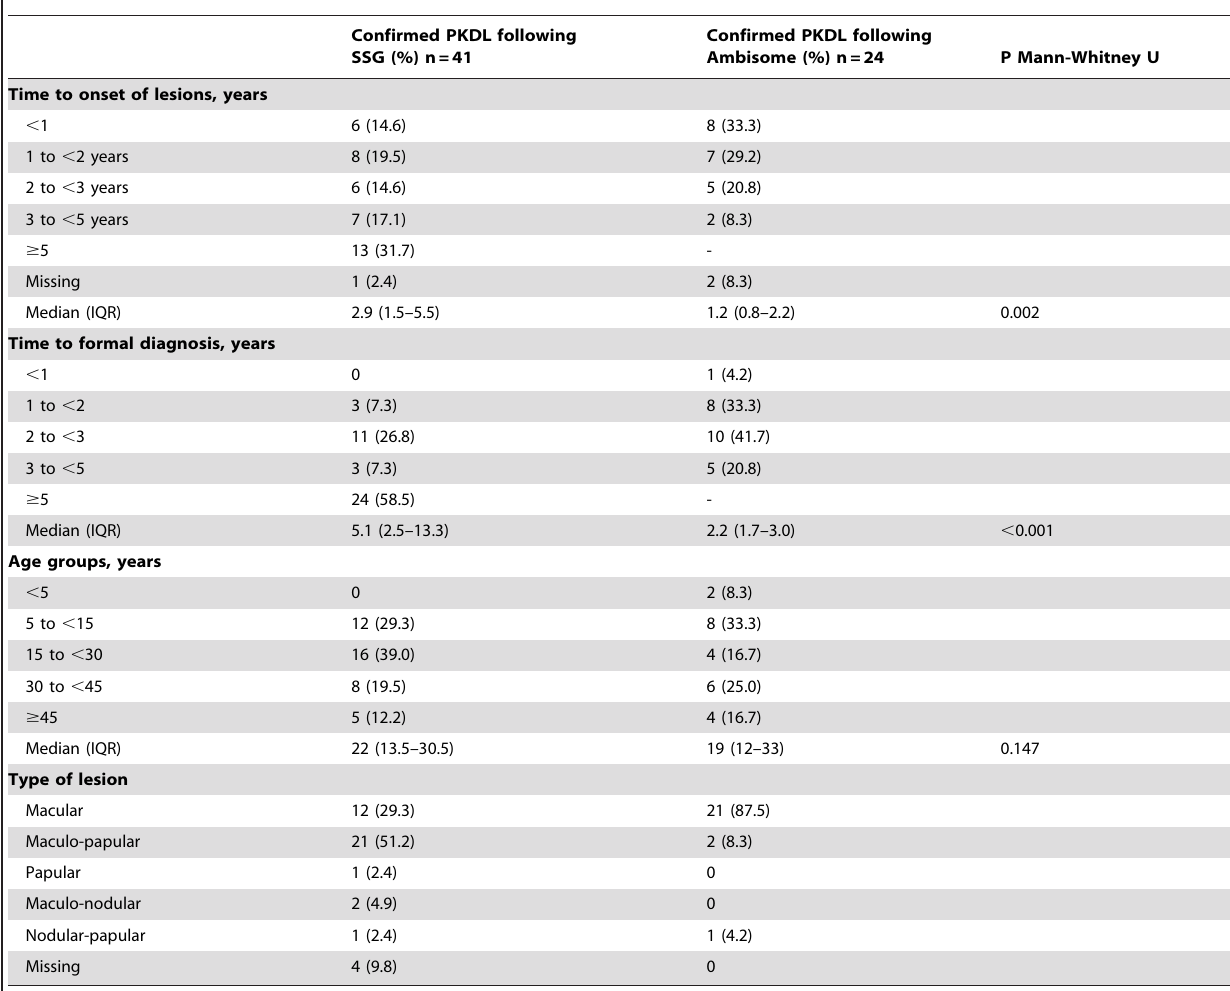
Table 2. Comparison of PKDL patients following treatment with SSG and